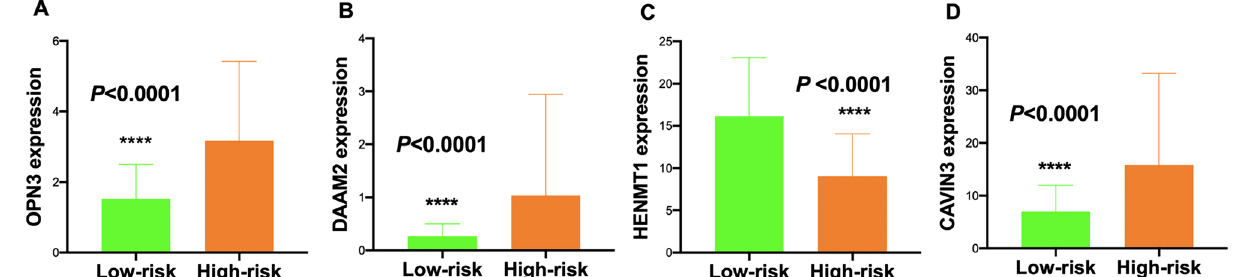
Figure 8. Comparison of the transcript levels of the 4 key mRNAs between the low-risk group and high-risk group. The expression levels of ( A ) OPN3, ( B ) DAAM2, and ( D ) CAVIN3 were higher but the expression level of ( C ) HENMT1 was lower in the high-risk group than those in the low-risk group. * P < 0.05; ** P < 0.01; *** P < 0.001; **** P < 0.0001 (unadjusted).